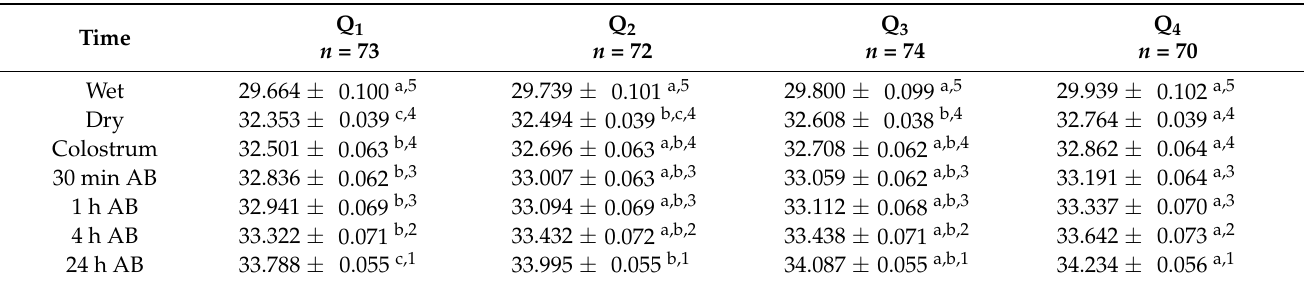
Table 5. Average of the temperature of abdominal (A) window at different times in newborn puppies classified into 4 groups according to weight.